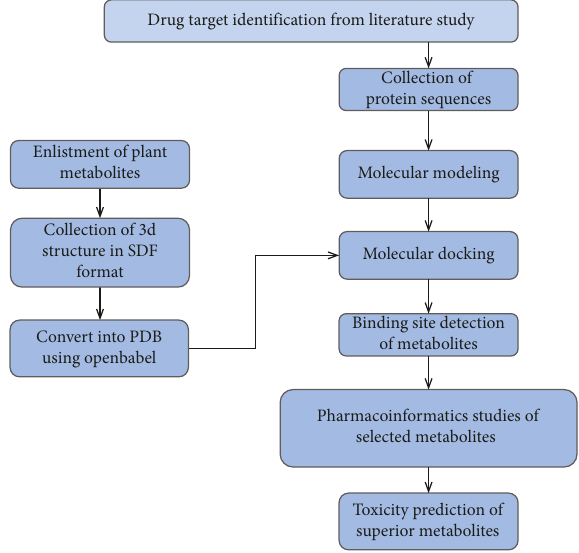
Figure 1: Overview of the